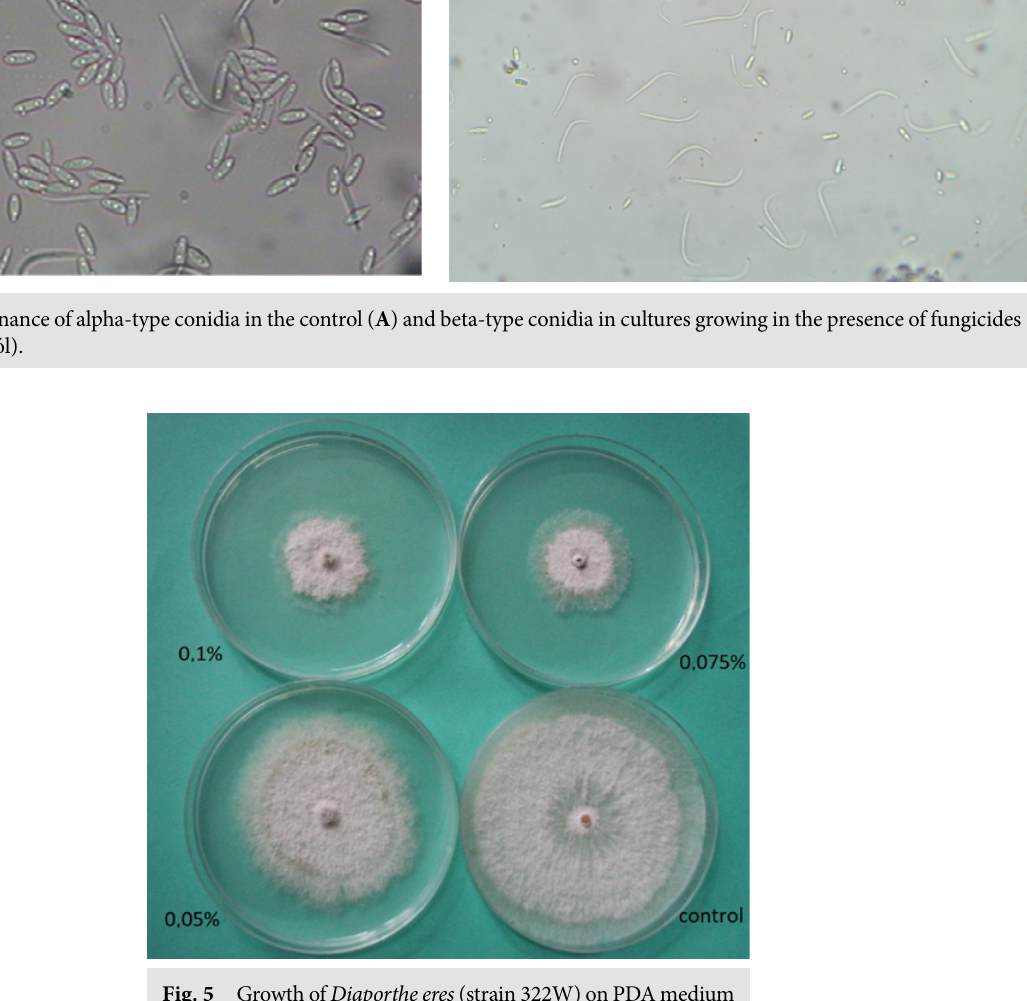
Fig. 5 Growth of Diaporthe eres (strain 322W) on PDA medium containing Biosept Active (photo B. Abramczyk).